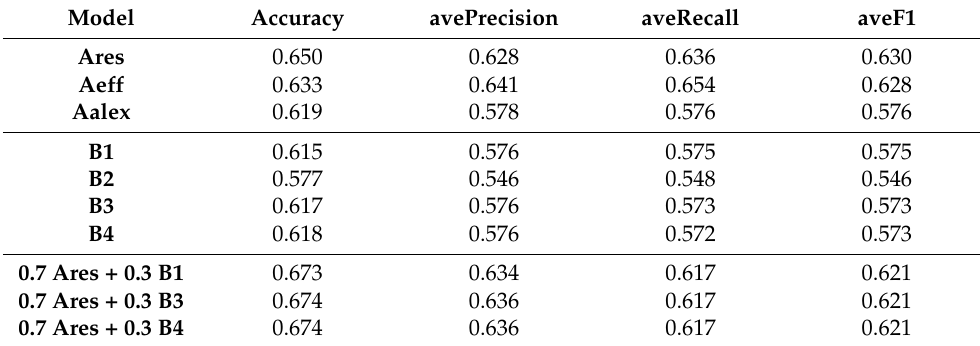
Table 5. The overall accuracy and the averages of precision, recall, and F1. Model Accuracy avePrecision